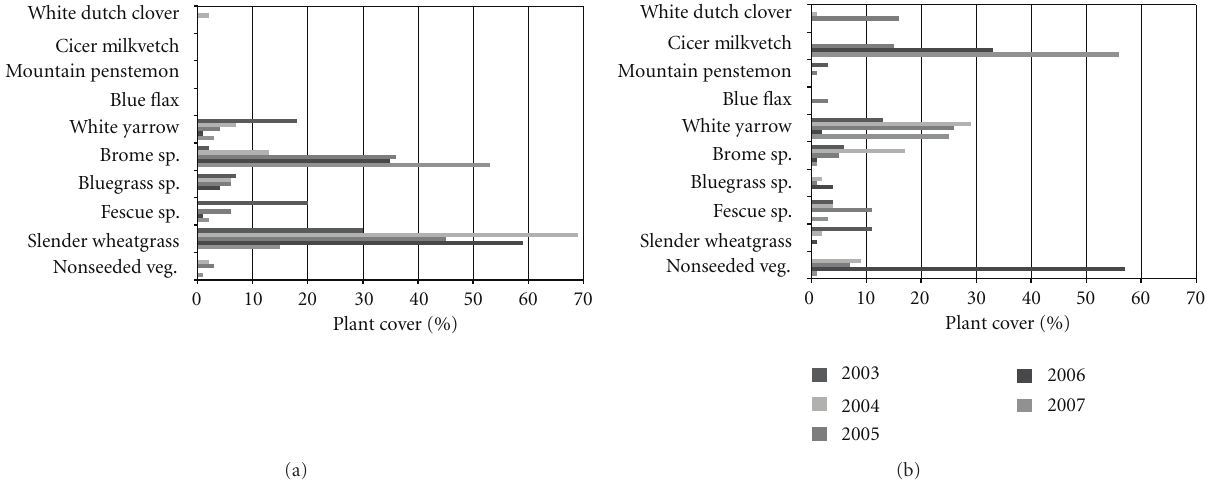
White dutch clover